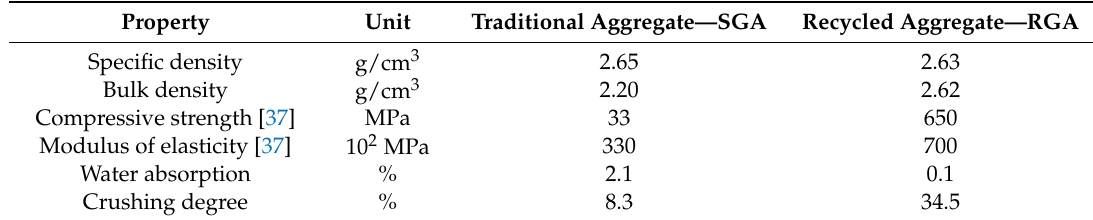
Table 4. Basic Properties of the Aggregates Used.